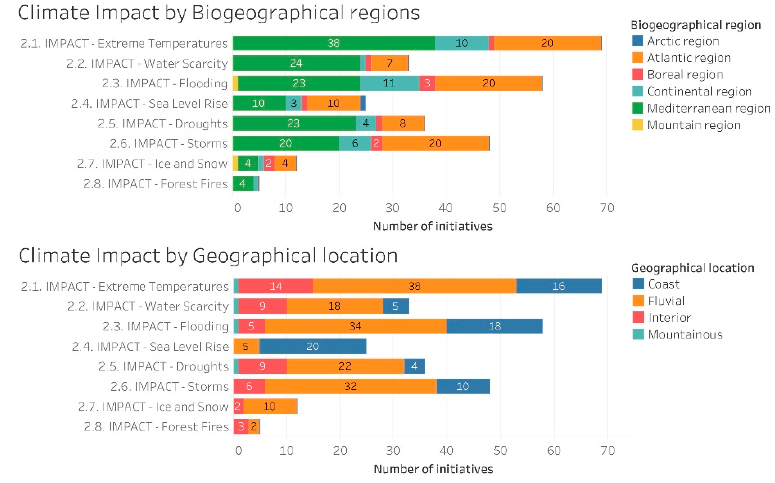
Figure 4. Distribution of Climate Impacts in different biogeographical regions ( top ) and different geographical locations ( bottom ). Source: Compiled by the authors from Mayors Adapt information [19].